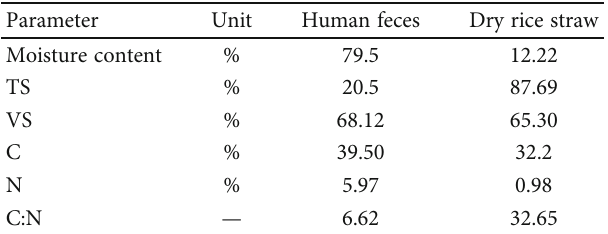
Table 2: Physiochemical analysis of